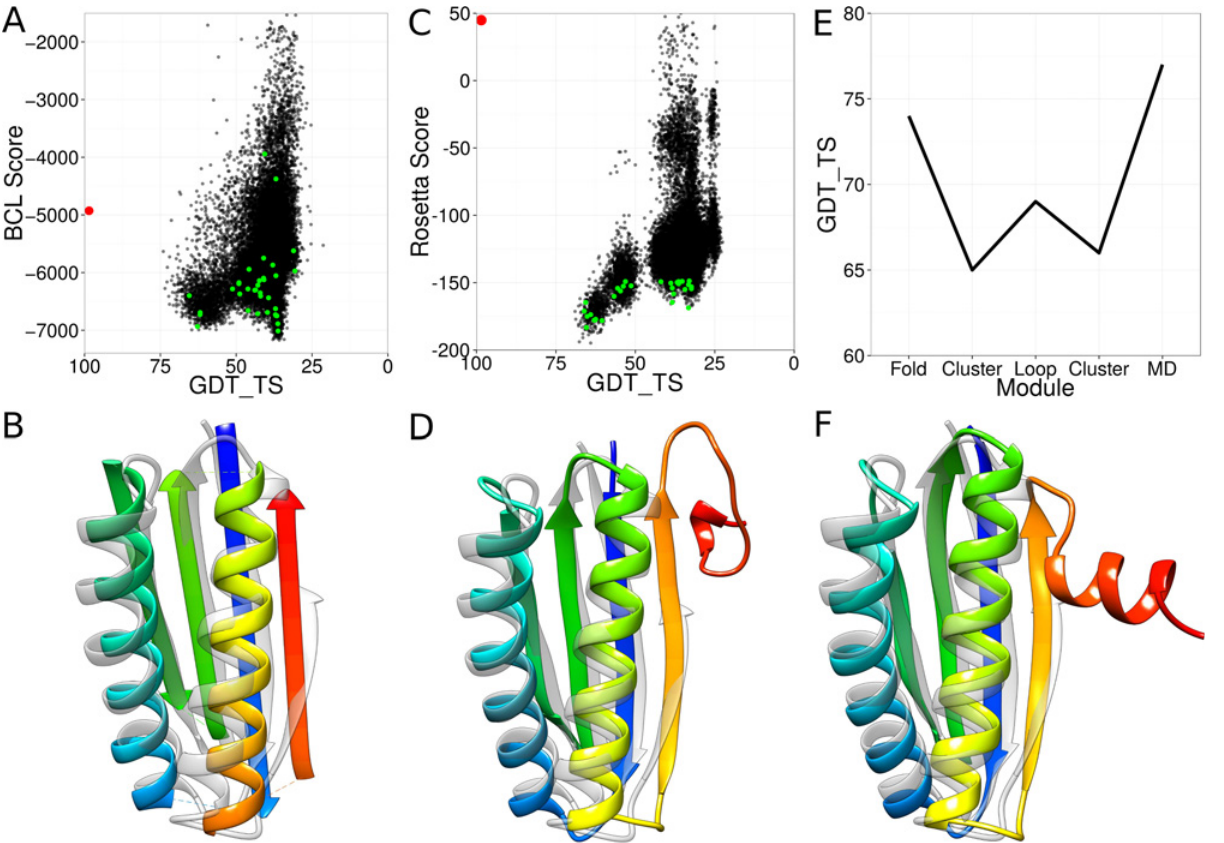
Fig 4. Case study of regular target T0769. (A) Results for the low-resolution topology search. Each black dot represents one sampled model. The NMR structure is shown in red. The green dots are the cluster medoids selected after the topology search. (B) Most accurate model after the topology search (rainbow) superimposed with the NMR structure (grey). (C) Results for high-resolution refinement and loop construction. Each black dot stands for one sampled model. The NMR structure is shown in red. The green dots are the cluster medoids selected after the high-resolution refinement. (D) Most accurate model after the high-resolution refinement (rainbow) superimposed with the NMR structure (grey). (E) Development of the GDT_TS of the most accurate model over the course of the pipeline. (F) Most accurate model after the molecular dynamics refinement (rainbow) superimposed with the NMR structure